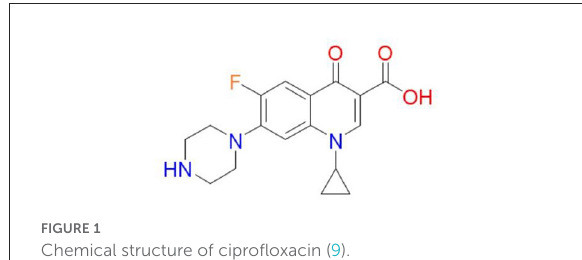
FIGURE1 Chemical structure of ciprofloxacin (9).